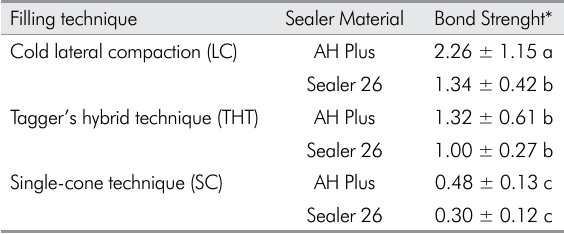
Table 1. Bond strength mean values and standard deviations (in MPa) according to the filling technique and sealer used.